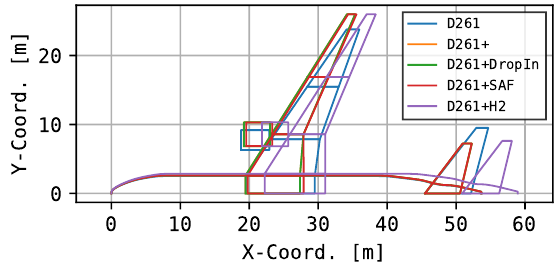
Figure 8. Generic top view of all